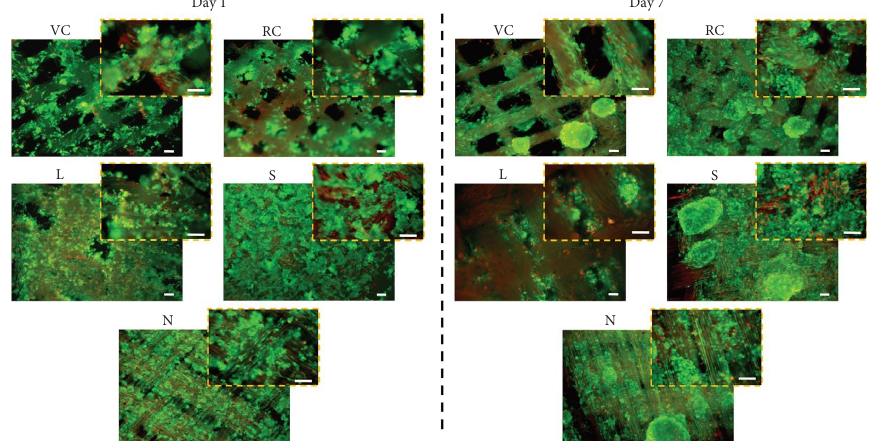
Figure 3: HepG2 cell culture on the textiles. Live/dead images of cells cultured on selected textiles at day 1 and 7 at magnifcations, 40x (scale bar: 200 μ m) and 100x (inset image; scale bar: 100 μ m).